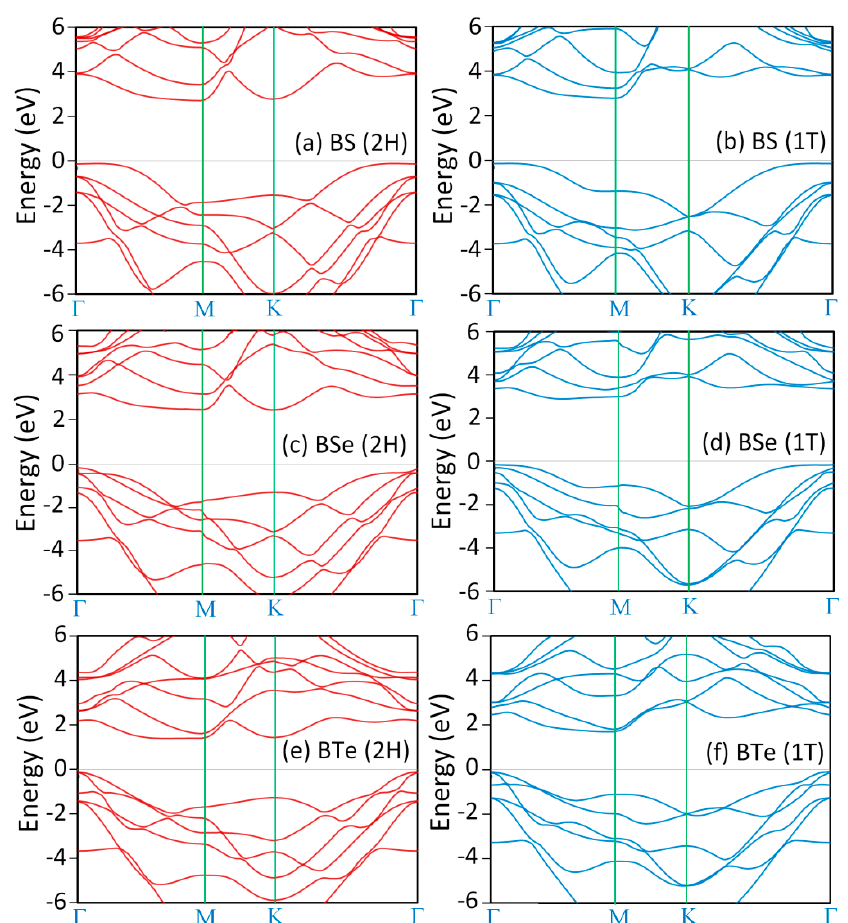
Figure 4. Band structure of single-layer BS, BSe, and BTe with 2H and 1T atomic lattices predicted by the PBE functional. The Fermi energy is aligned to zero.